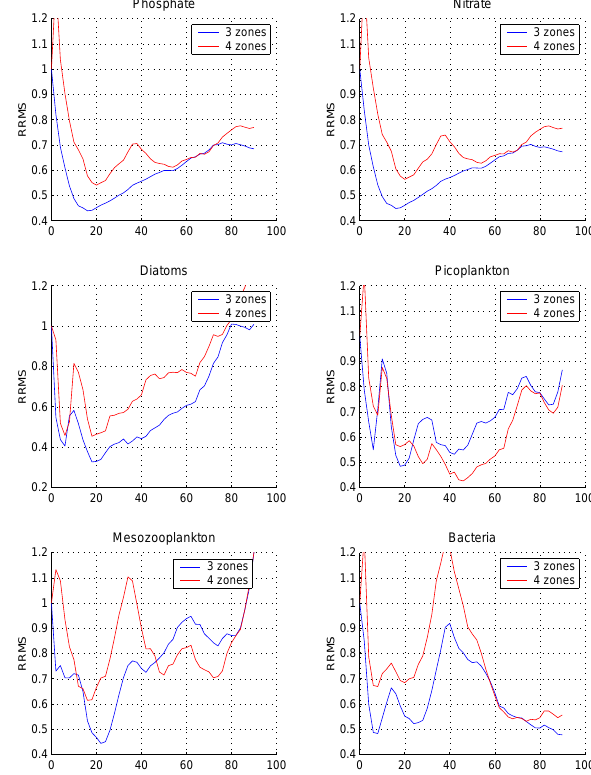
Fig. 8. Evolution in time of phosphate, nitrate, diatoms, picoplank- ton, mesozooplankton and bacteria RRMS from the SFPLEK filter assimilating profiles using global-local EOFs from 3 and 4 horizon- tal and 4 sub-domains (as shown in Fig